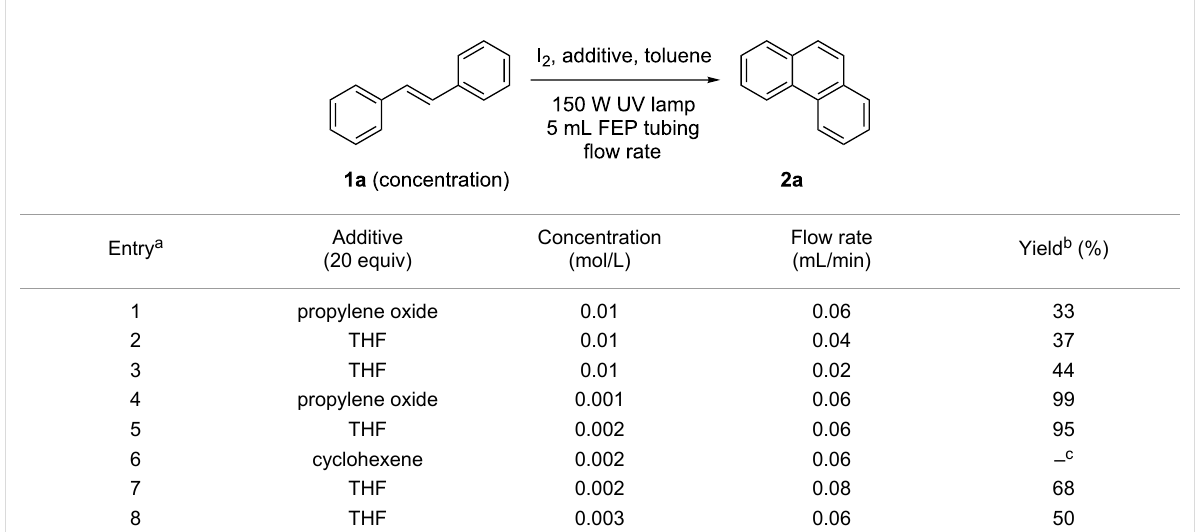
Table 1: Proof of principle and screening of reaction